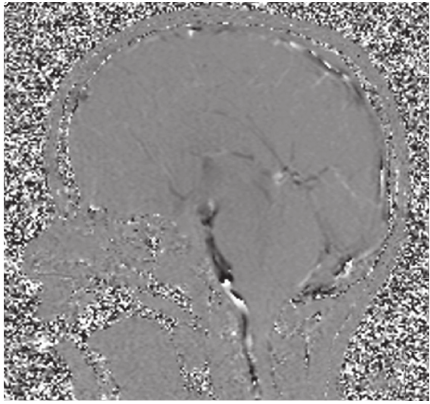
Figure 2: Postoperative MRI 2D phase contrast with third ventricle CSF flow